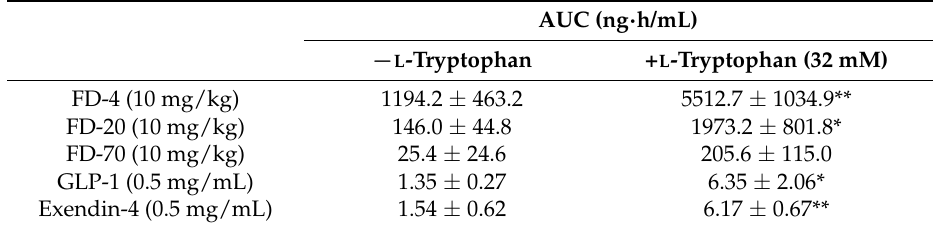
Figure 4. Time profiles of plasma concentrations of peptide drugs (GLP-1 and Exendin-4) after their in situ administration with or without L -tryptophan (32 mM) into rat ileal loop. Panels ( A ) and ( B ) show the absorption of GLP-1 and Exendin-4, respectively. Each data point represents the mean ± SEM of N = 4. Table 2. AUCs following in situ administration of dextrans (FD-4, FD-20 and FD-70) with L -tryptophan into rat ileal loop.